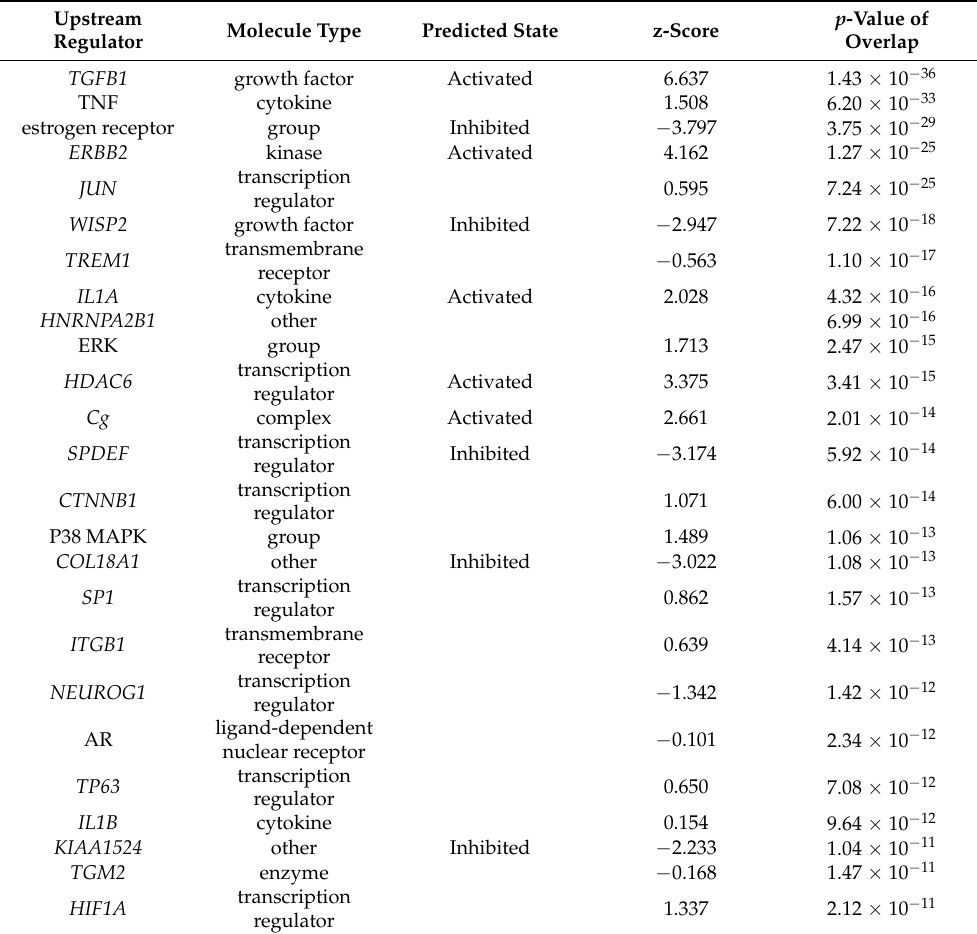
Table 2. Predicted upstream regulators in A549 cells treated with TGF- β